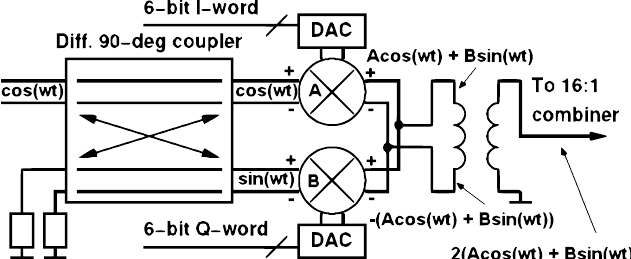
Fig. 2 Block-level representation of a single-receiver beamformer path, highlighting the signal behavior at each cross section of the I-Q phase